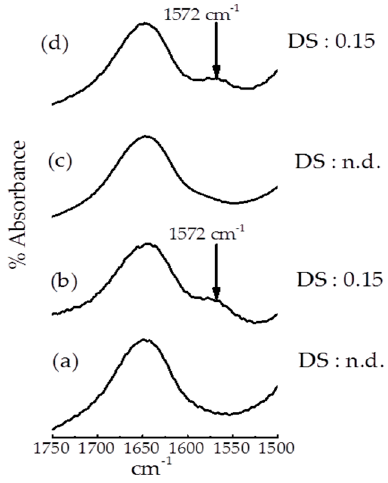
Figure 1. FTIR spectra for ( a ) native, ( b ) succinylated, ( c ) annealed, and ( d ) dual modified corn starch.